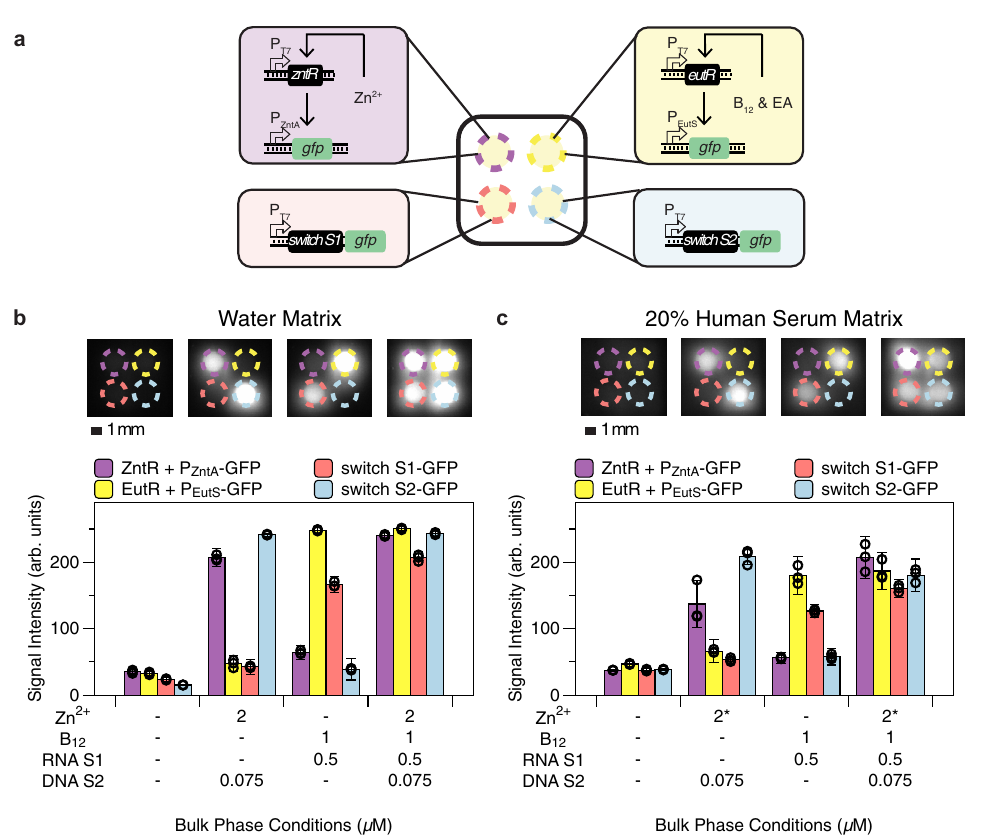
Fig. 5 Simultaneous detection of multiple clinically relevant biomarkers across multiple molecular classes in water and 20% human serum matrices. Reactions were incubated at 37 °C for 3 h. a Schematic of membrane-less protocell array setup for multimodal, simultaneous detection of diverse classes of clinically relevant biomarkers. Purple and yellow circles indicate micro-basins containing zinc and vitamin B 12 sensors, respectively. Red and blue circles indicate micro-basins containing Stx1 (S1) and Stx2 (S2) toehold switches, respectively. b Representative fl uorescence image (top) and quanti fi cation of the representative image and its replicates (bottom), demonstrating multimodal target measurement using protocell arrays with simultaneous detection of ion, small molecule, RNA, and DNA targets from the same bulk phase. Data for each biological replicate are provided in Supplementary Fig. 11. c Multimodal target detection in a 20% human serum matrix. Representative fl uorescence image (top) and quanti fi cation of the representative image and its replicates (bottom), demonstrating the robustness of protocell arrays to a complex sample matrix. The asterisk (*) next to the zinc concentration indicates the total zinc concentration is 2 µ M in the bulk phase after accounting for the zinc remaining in chelated human serum (Supplementary Fig. 14). Of note, the sensor plasmid concentrations were increased in c compared to b to yield comparable output signal; this tuning was necessary due to the decrease in protein expression that occurs in human serum 5 . Data for each biological replicate are provided in Supplementary Fig. 13. Data are presented as mean values ± SD of 9 replicates (3 biological replicates× 3 technical replicates). Hollow circles indicate the mean of each biological replicate. Scale bar is 1 mm. Details on CFE lysates used, plasmid concentrations, and reaction additives are provided in Supplementary Table